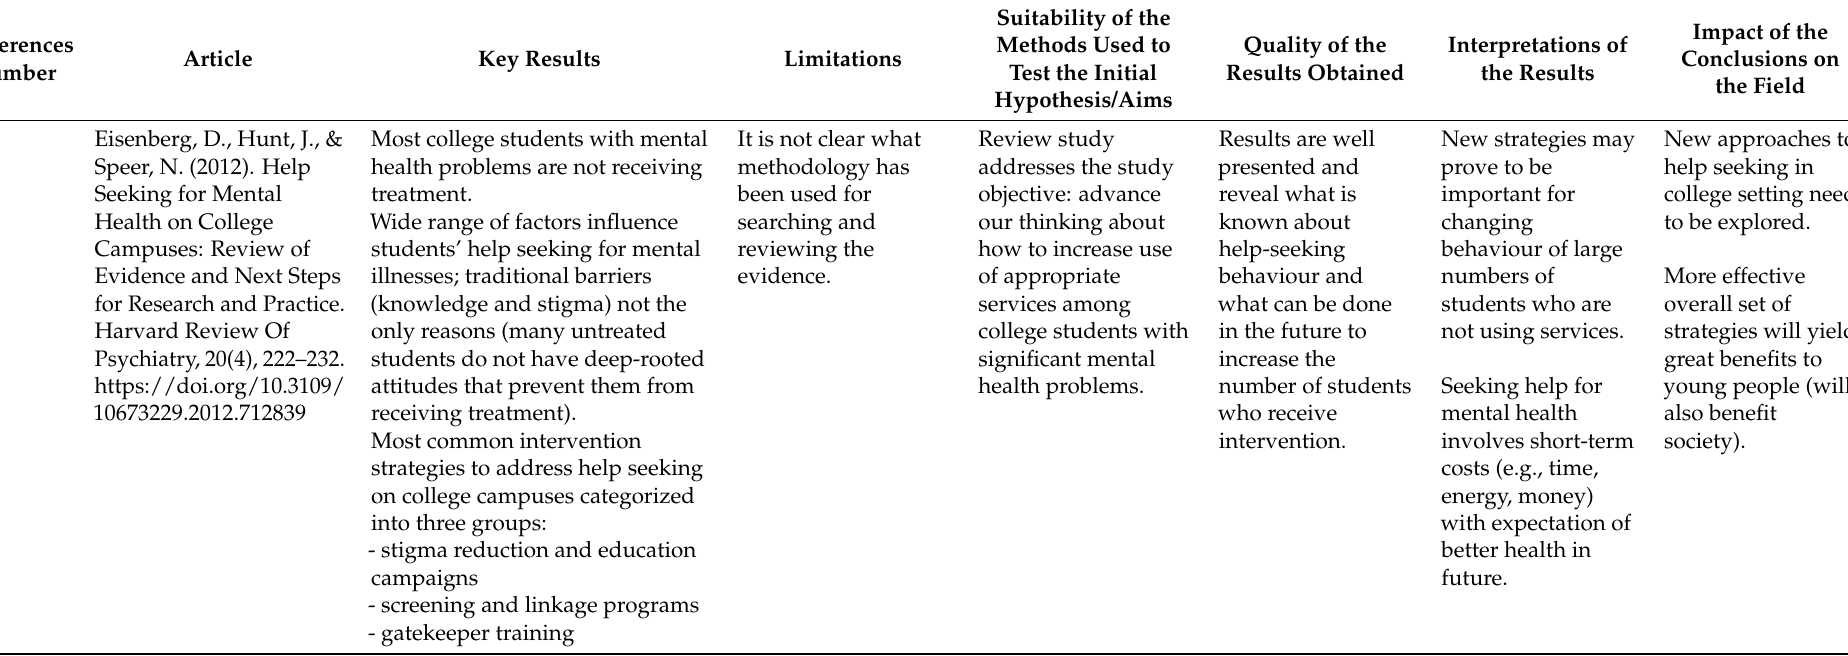
Table 3. Critical appraisal of articles reviewed based on Ferrari’s [15] criteria and